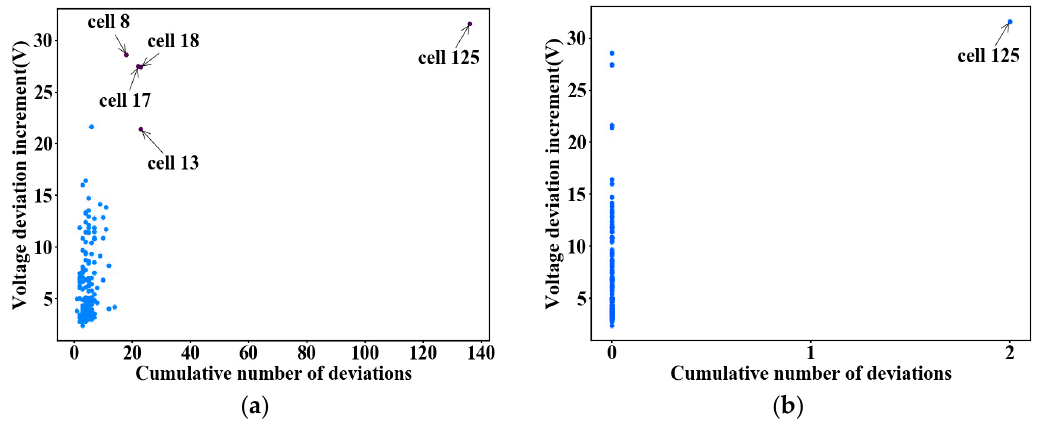
Figure 5. The clustering results with different L : ( a ) L = ± 0.05 V ; ( b ) L = ± 0.3 V .